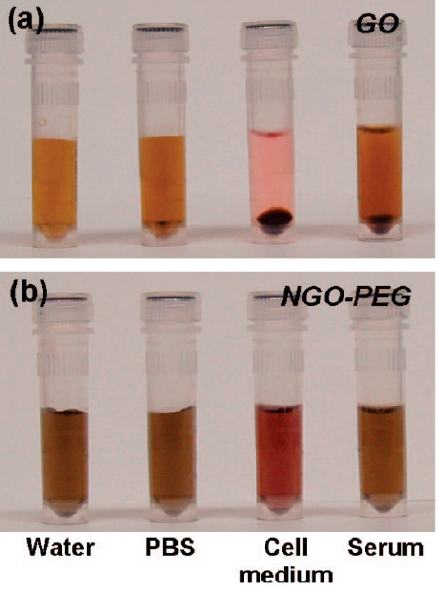
Figure 11. Photos of ( a ) GO and ( b ) NGO-PEG solutions that dissolved against different solvents. Reprinted with permission from References [137]